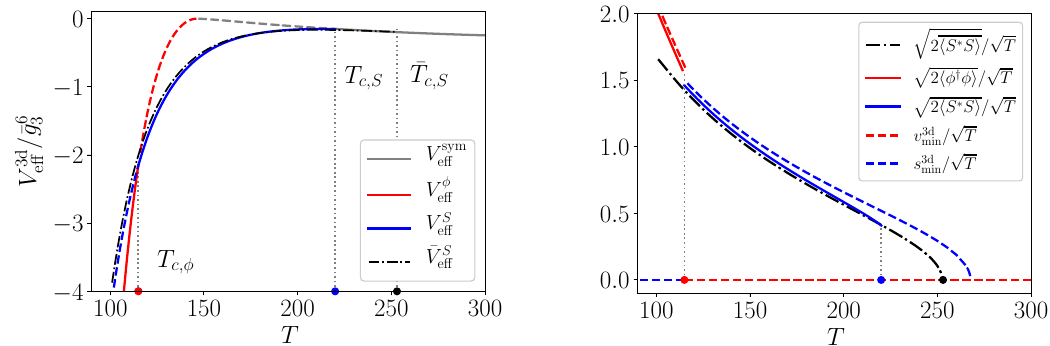
Figure 3 . Left: value of the effective potential as function of temperature T in the symmetric (grey), Higgs (red) and singlet (blue) phase. Solid lines illustrate the global minimum. For dashed lines the potential also develops an imaginary part, signalling that the corresponding phase is not a stable minimum. Each phase is present only at limited T -intervals. Outside these ranges, the value of the effective potential is purely imaginary. Critical temperatures are determined from the intersection points, illustrated by dotted vertical lines and dots on the x -axis. The dotted-dashed black line describes the singlet phase in the EFT setup with a radiative barrier from the heavy Higgs. Right: The square root of the gauge-invariant singlet (solid blue) and Higgs (solid red) condensates are shown in a temperature range for which they are real together with the singlet condensate in the heavy Higgs EFT (dot-dashed black), in analogy to the left panel. For comparison, the dashed lines show the gauge-dependent values of the background fields in the global minima of the Landau gauge effective